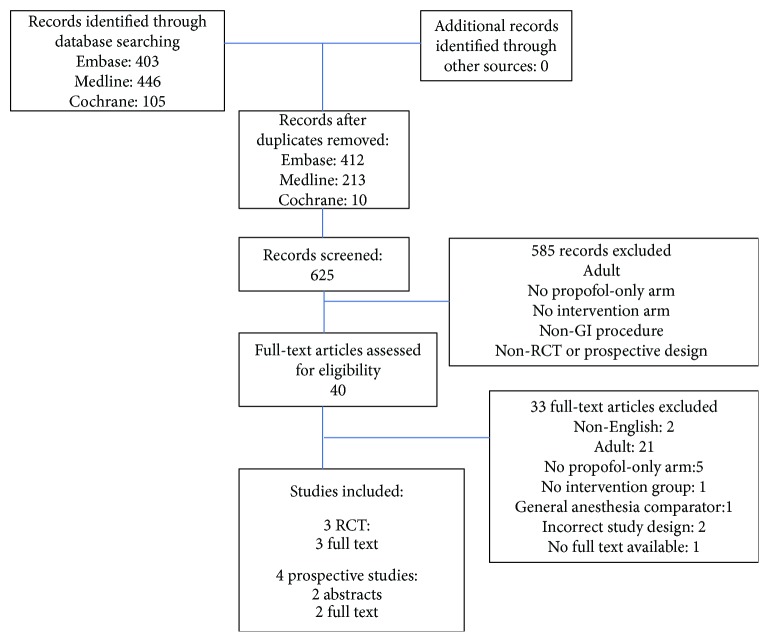
Prisma flow diagram. Retrieved studies and process of screening. Total included studies included 3 randomized controlled trials and 4 prospective cohort studies. All exclusion criteria were determined a priori.